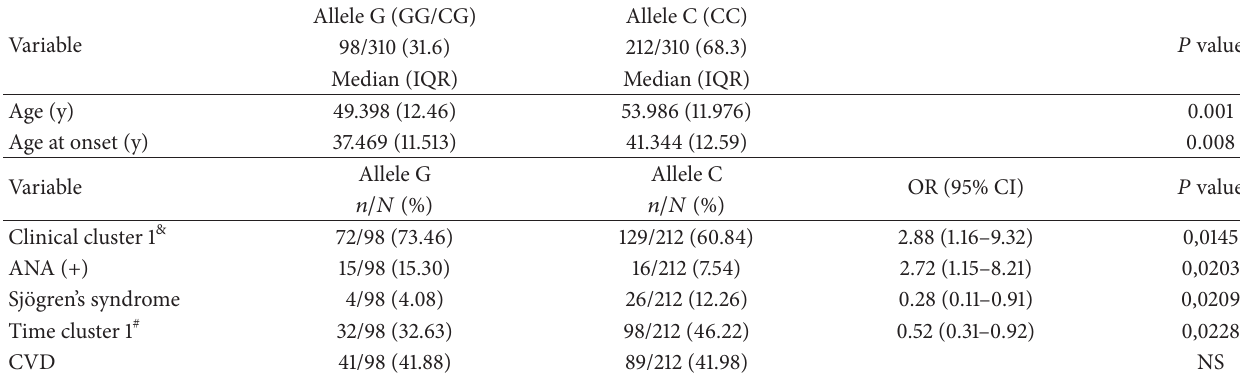
Table 5: Characteristics associated with allele G of the GDF15 rs1058587 SNP in RA